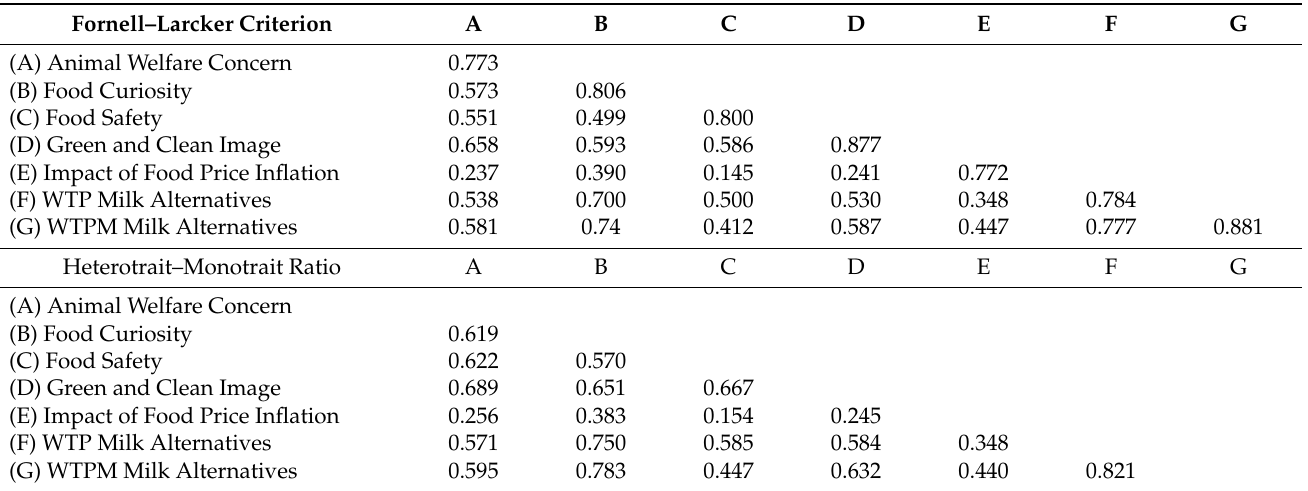
Table 3. Discriminant validity across